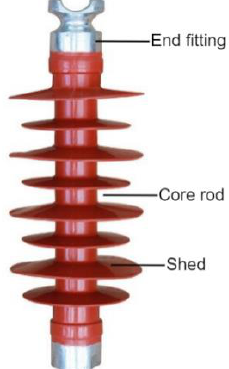
Figure 1. Silicone rubber insulator.